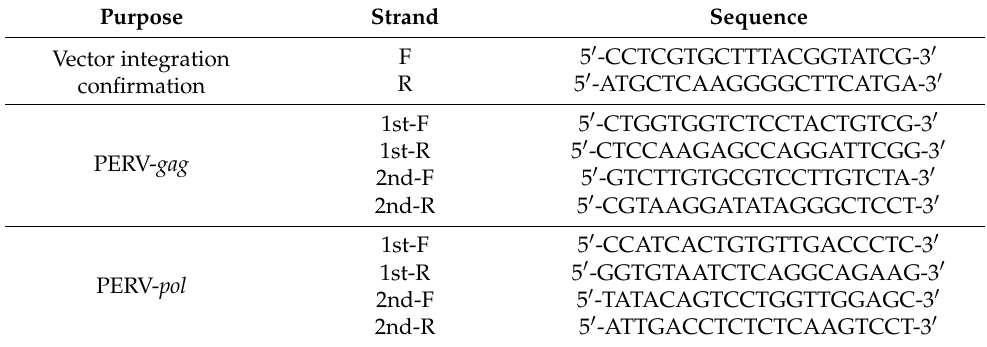
Table 2. Primer sequences used in the